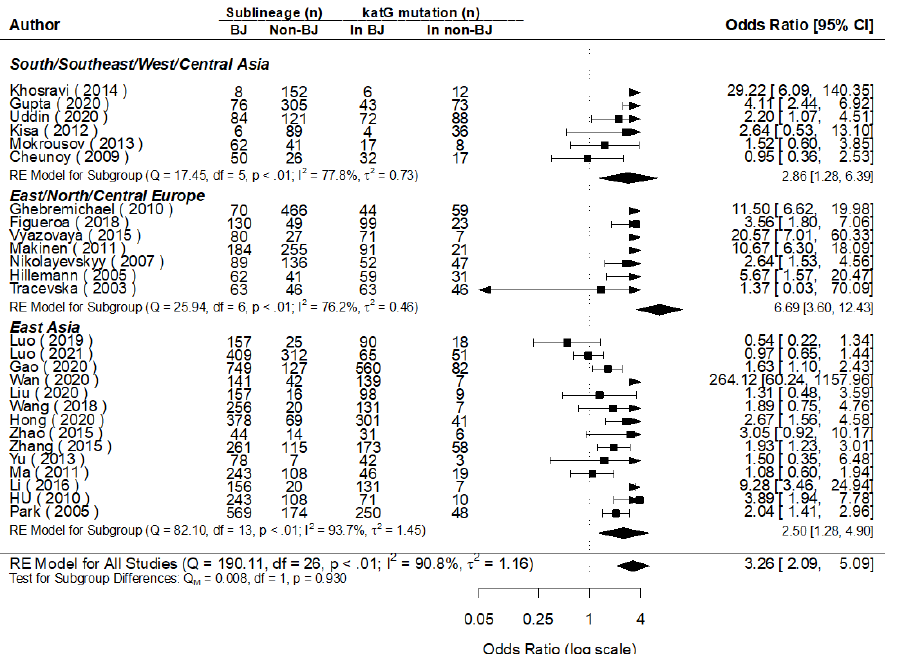
Figure 6. MA for the mutations of katG in Beijing and non-Beijing Strains (CI: confidence interval; BJ: Beijing strain; Non-BJ: non-Beijing strain).